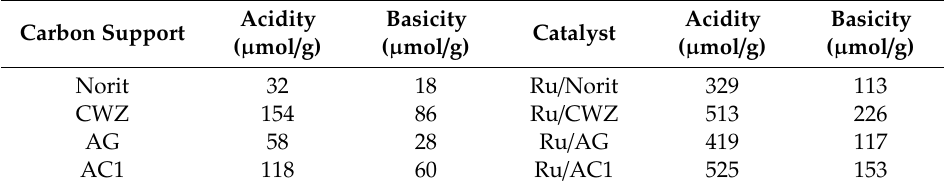
Table 2. Acid–base properties of selected carbon materials and ruthenium catalysts.